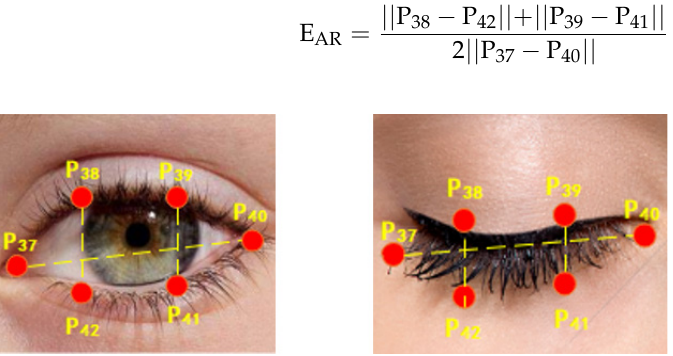
Figure 4. Eye feature points.